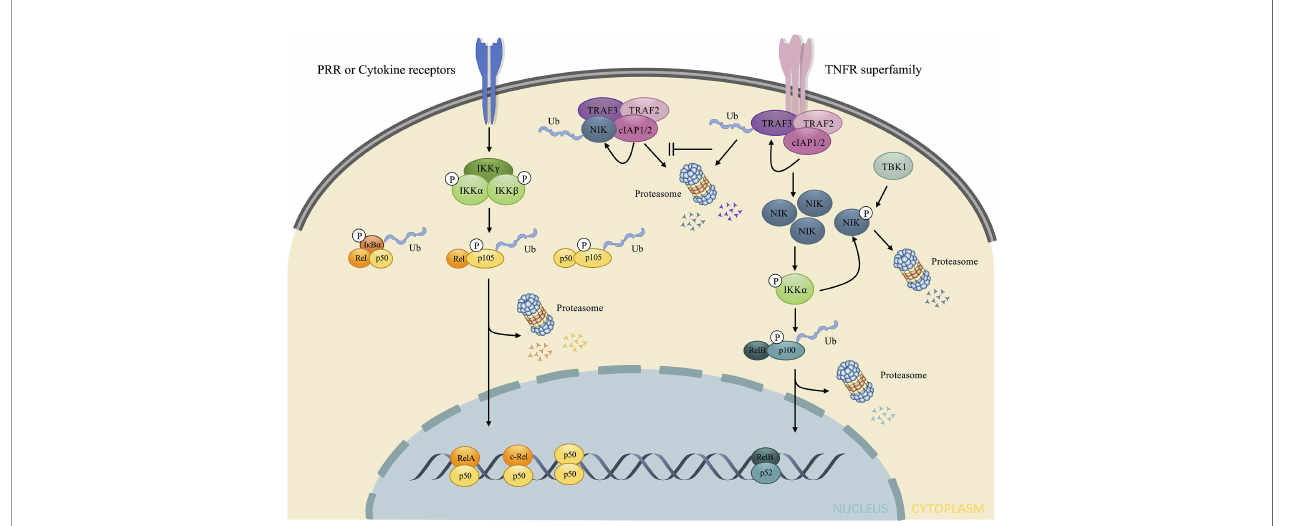
FIGURE 1 | Brief illustration of the activation and regulation of the two major NF- k B signaling pathway. The canonical pathway is induced downstream of the stimulation of LPS and cytokines. Such stimuli mediate the activation of IKK, consisting of three subunits: IKK a , IKK b , and IKK g , which in turn phosphorylates and elicits the ubiquitin dependent processing of I k B and p105, leading to the nuclear translocation of RelA/p50, c-Rel/p50, p50/p50 dimers and the regulation of target gene expression. The non-canonical pathway is induced downstream of TNFR superfamily. In the absence of stimuli, NIK undergoes ubiquitin-dependent degradation mediated by NIK ubiquitin ligase, composed of TRAF3, TRAF2 and cIAP1/2. Under stimuli, TRAF3 undergoes ubiquitin-dependent degradation, which allows the accumulation of NIK. NIK directly phosphorylates and activates IKK a , contributing to the phosphorylation and ubiquitin dependent processing of p100 to p52. The nuclear accumulation of p52/RelB dimers changes transcriptional activity of target genes. The excessive NIK can also be evacuated via negative feedback mechanisms. IKK a can phosphorylate NIK, resulting in the direct proteasome-mediated degradation without the involvement of NIK ubiquitin ligase. TBK1 downstream of CD40 and BAFF also phosphorylates NIK and induces degradation. LPS, lipopolysaccharides; IKK, I k B kinase; TNFR, tumor necrosis factor receptor; NIK, NF- k B inducing kinase; TBK1, TANK-binding kinase 1; BAFF, B-cell activating factor belonging to the TNF